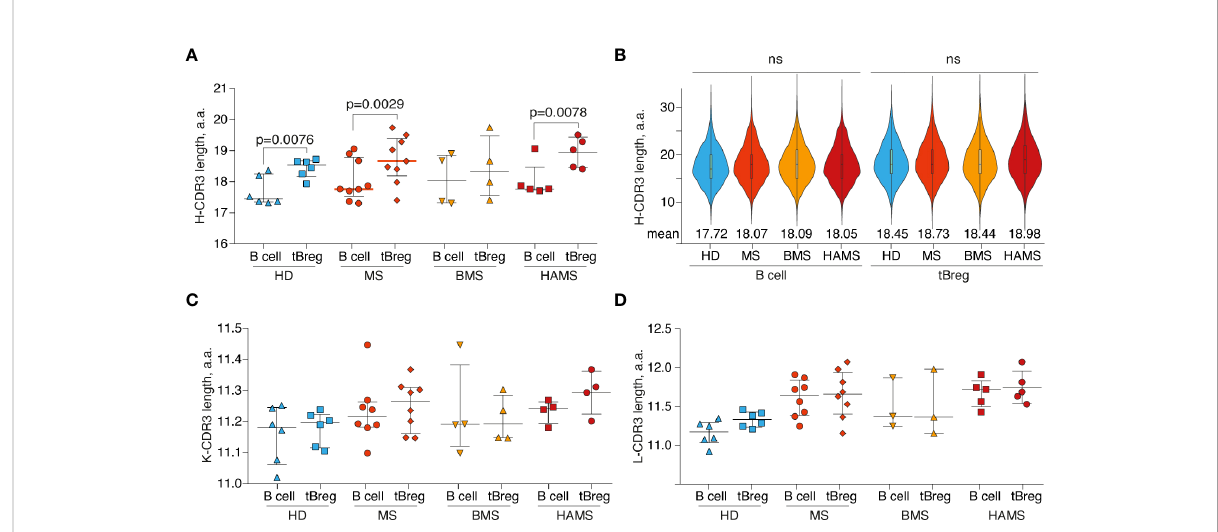
FIGURE 3 Differences in CDR3 length. The distribution of B cell subset CDR3 amino acid length for heavy (A) , kappa (C) , and lambda (D) light chains. Bar and line plots show mean ± SD. (B) The CDR3 amino acid length distribution for IGVH clonotypes in different B cell subsets. To balance the sample size, an equal number of clonotypes ( n = 1000) were randomly sampled from each donor repertoire. Rare clonotypes with CDR3 length <6 a.a. or >35 a.a. were excluded. Mean values are displayed by numbers. The difference in CDR3 length between tBreg and total B cell fraction was analyzed by the ratio paired T -test. The difference in CDR3 length between donor groups was assessed using the Mann Whitney test. Only statistically signi fi cant p -values are indicated. The total CD19 + B cell pool and transitional regulatory CD19 + CD24 high CD38 high subpopulation from peripheral blood are designated as B cells and tBregs, respectively. ns , not signi fi